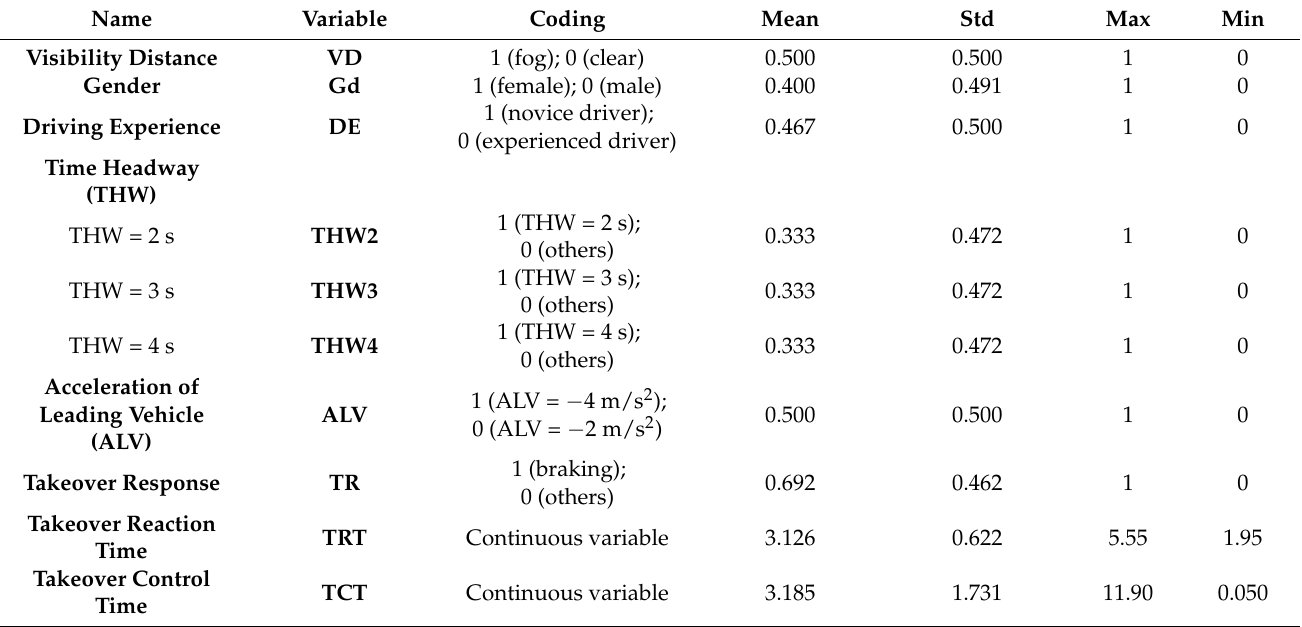
Table 7. Descriptive statistics of the explanatory